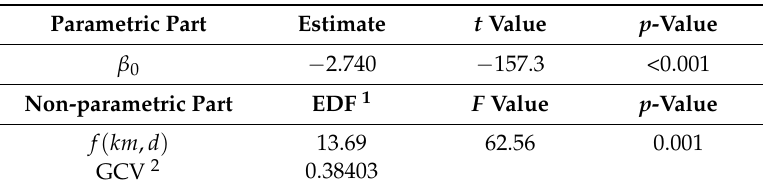
Table 5. Results for model